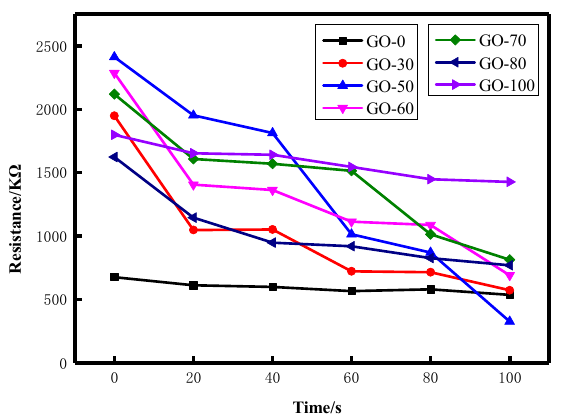
Figure 8. Static resistance curves of graphite oxide samples prepared at different reaction temperatures.